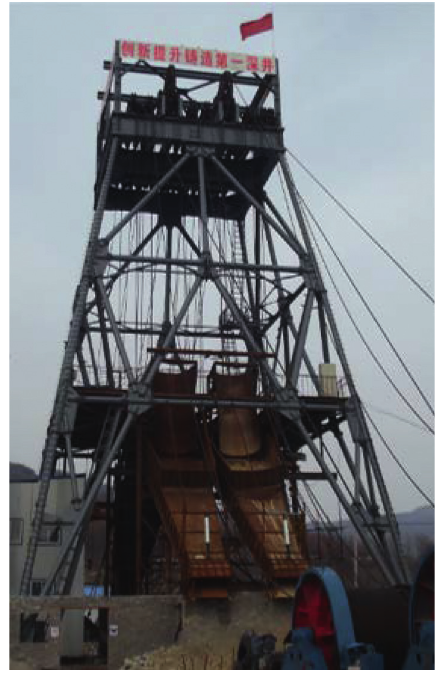
Figure 2: The working condition of sinking headframe in the field.